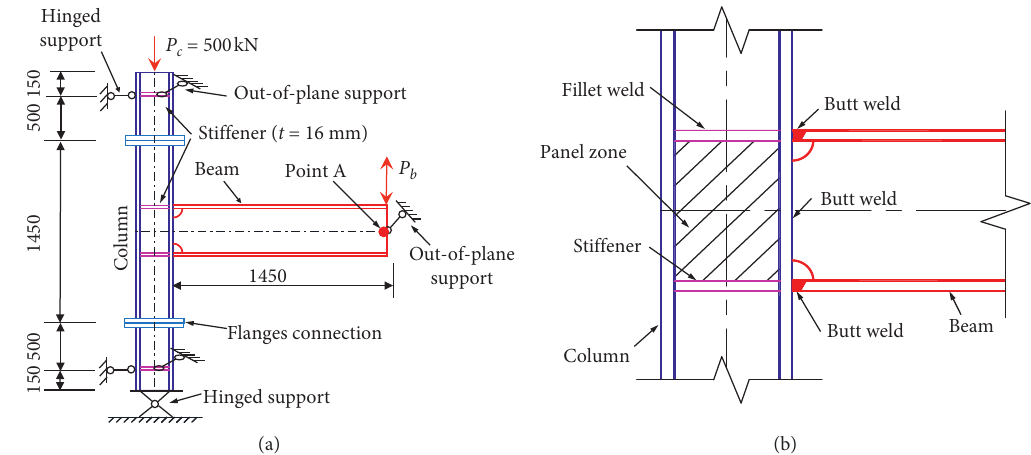
Figure 1: Test model and details of the connection. (a) Test model (length unit: mm). (b) Details of the all-welded connection.